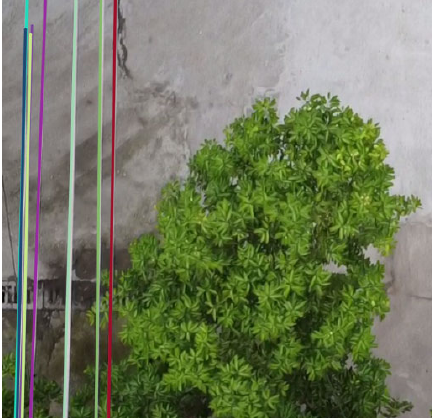
Figure 4. The model detects one single line for multi-times. The transmission line on the left side of the figure was detected repeatedly.